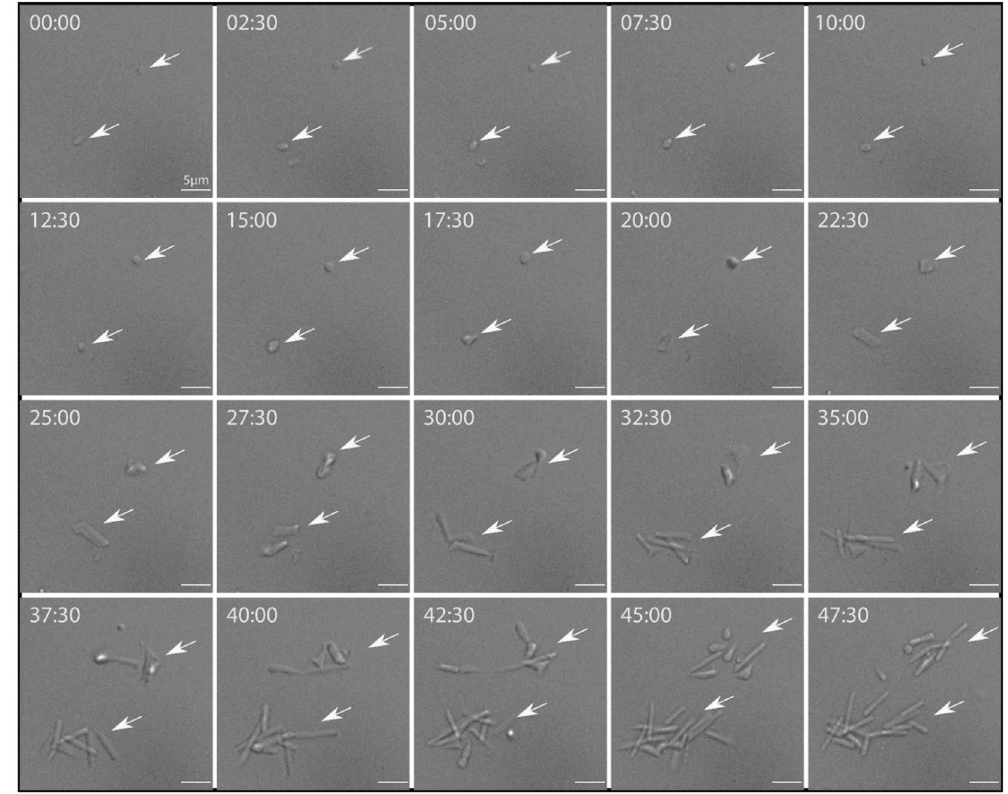
Figure 4. Time-lapse light microscopy. Hbt. salinarum morphological changes were monitored during recovery in 4.2 M NaCl growth medium after a low-salt shock (1 h) at 0.5 M. Cells were grown at 37 °C in the microscopy chamber and observed by Dichroic Interference Contrast. Images were collected every 30 minutes over a period of 48